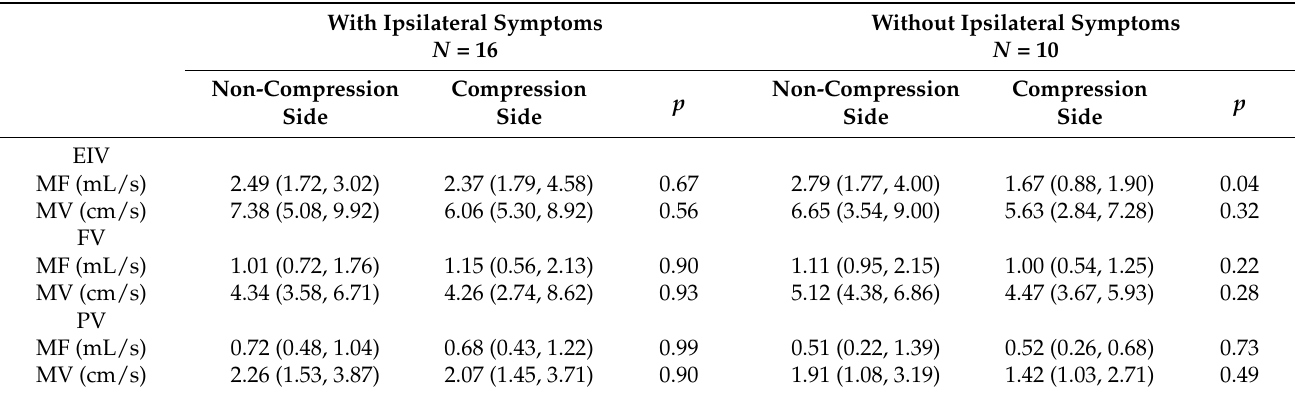
Table 3. Analysis of bilateral lower extremities of the patients with unilateral common iliac venous compression but without deep vein